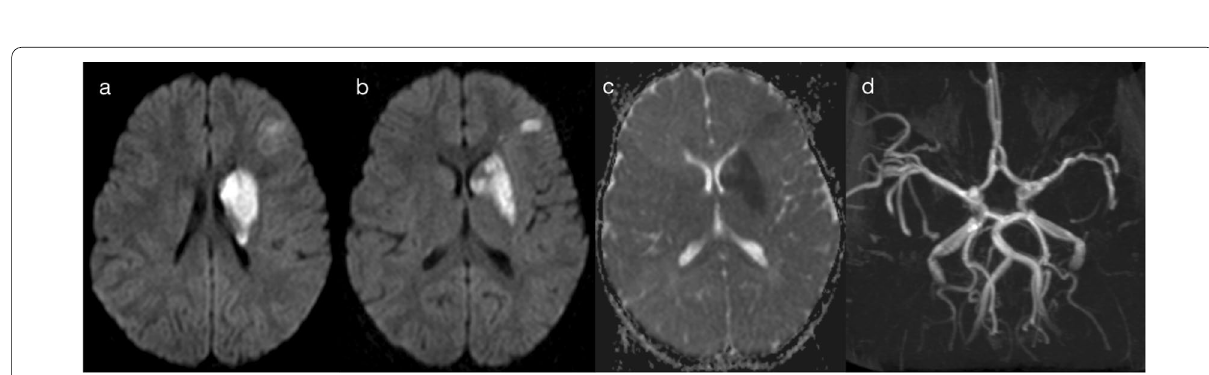
Fig. 7 Restricted diffusion in supratentorial grey matter—vascular territory infarct (Pattern 2C). 2‑year‑old child with right upper and lower limb weakness in the setting of prior varicella infection (IgG positive), in keeping with post‑varicella arteriopathy. DWI ( a , b ) and apparent diffusion coefficient (ADC) map ( c ) were consistent with an acute left caudato‑lenticular infarct and a small infarct within the left frontal lobe. MR angiography ( d ) demonstrated left middle cerebral arteriopathy